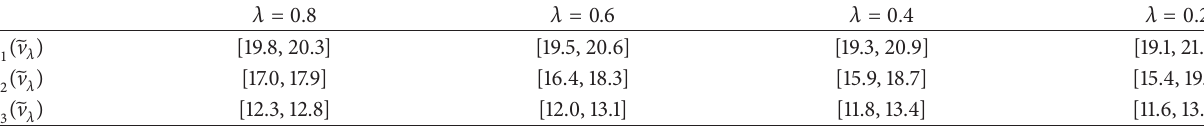
Table 1: Interval Hukuhara-Shapley values for different 𝜆 -level of decision-makers. 𝜆 = 0.8 𝜆 =